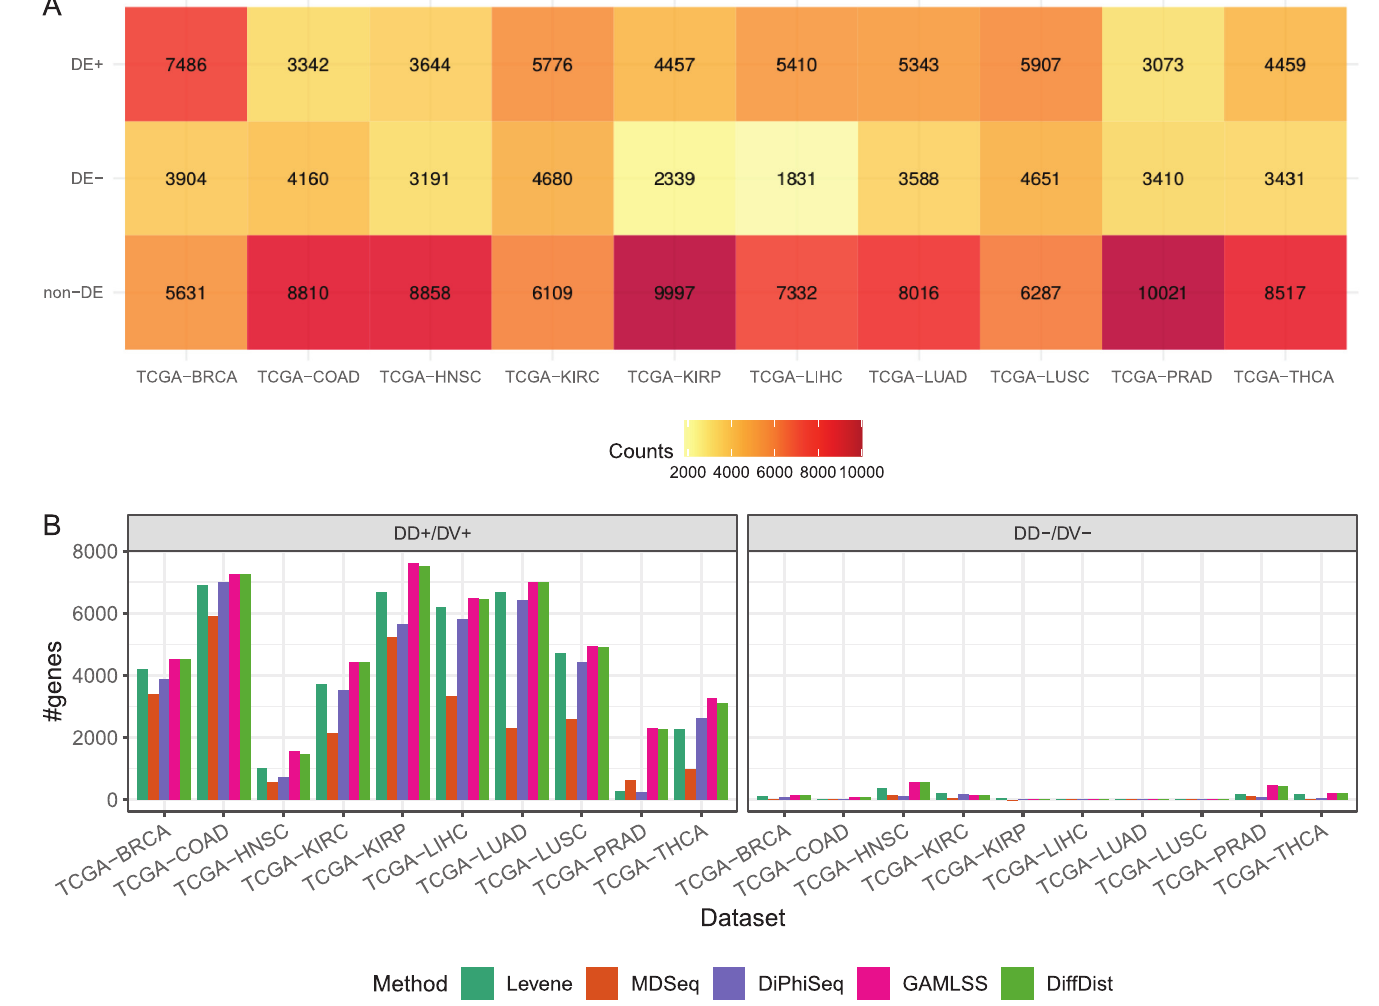
Fig 4. Differentially dispersed genes among non-differentially expressed genes for each TCGA dataset. (A) Number of differentially expressed (DE) genes separated between those upregulated in tumors (DE+) and those downregulated in tumors (DE-) detected by MDSeq per TCGA dataset. (B) Number of differentially dispersed (DD) genes among non-DE genes separated between those overdispersed in tumors (DD+) and those underdispersed in tumors (DD-), as detected by Levene’s test, MDSeq, DiPhiSeq, GAMLSS and DiffDist, per TCGA dataset.